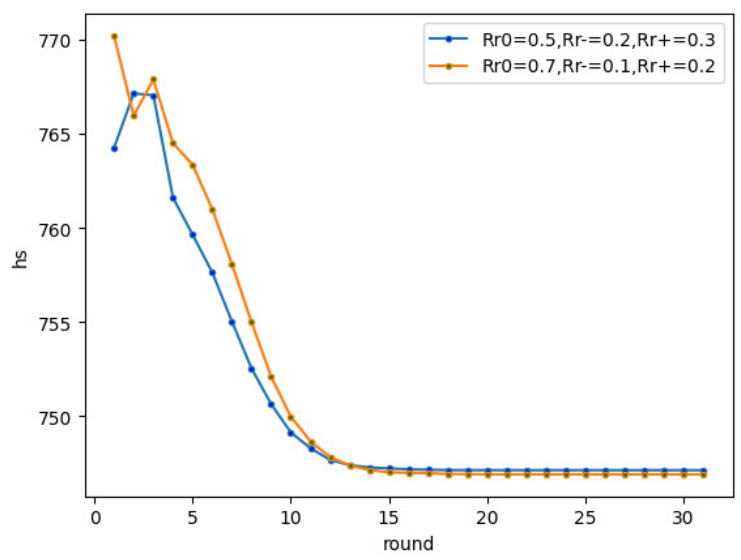
Figure 19. Effects of different initial ratios of the neutral edge: h s changes with time.